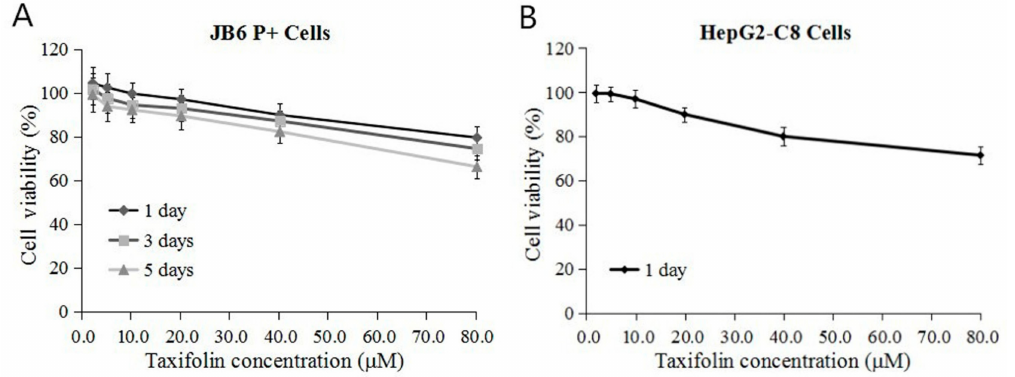
Figure 2. Cell viability of JB6 P+ cells and HepG2-C8 cells after treatment by TAX. After incubation for 24 h, the cells were treated with either dimethyl sulfoxide (DMSO) or different concentrations of TAX. Cell viability was determined using the 3-(4,5-dimethylthiazol-2-yl)-5- (3-carboxymethoxyphenyl)-2-(4-sulfophenyl)-2H-tetrazolium (MTS) assay with different subsequent treatments. ( A ) JB6 P+ cells were treated by TAX for one, three and five days at different concentrations (2.5 to 80 µ M); ( B ) HepG2-C8 cells were treated by TAX for one day at different concentrations (2.5 to 80 µ M). The data are expressed as the mean ± standard deviation (SD) ( n =